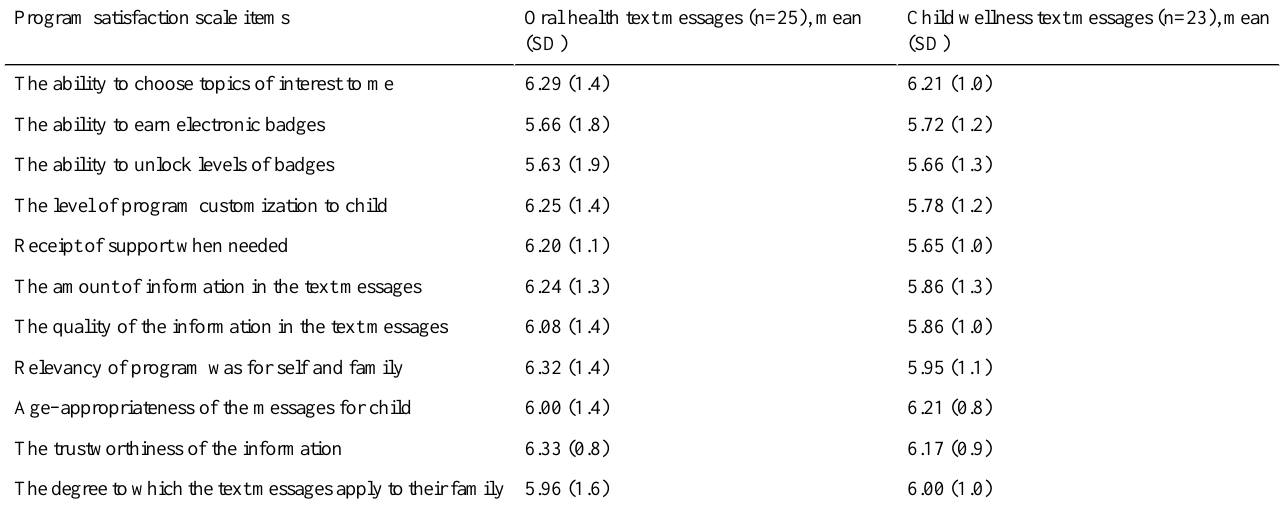
Table 2. Participant's satisfaction with the text message program.